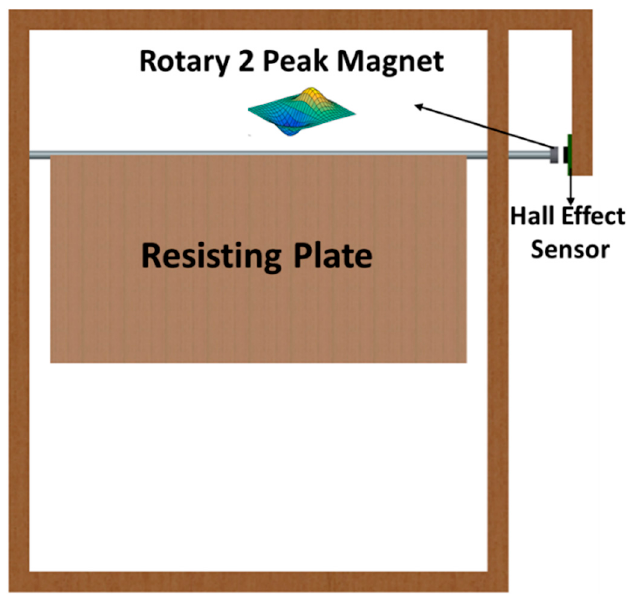
Figure 1. Air-Odo Computed Aided Design (CAD) designed model.